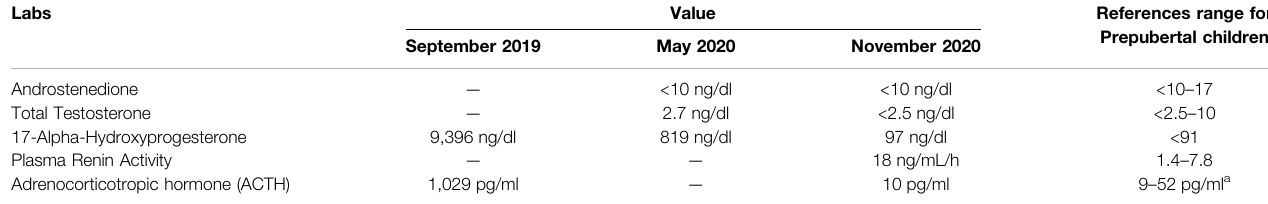
TABLE 2 | Laboratory